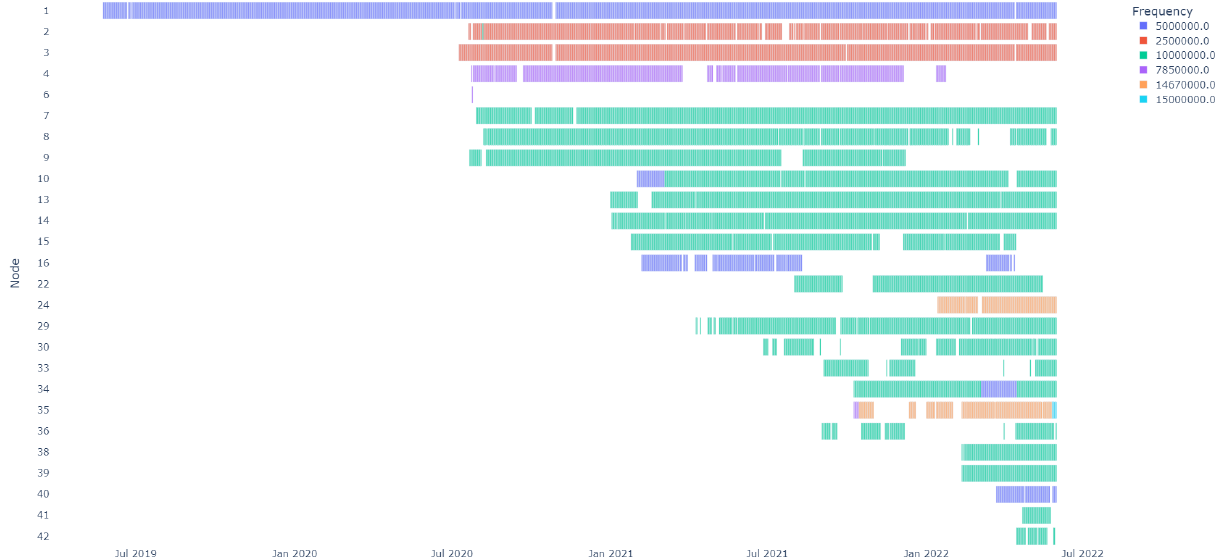
Figure 4. A data inventory, produced with a Gantt plotting tool in Plotly Express (Plotly Technologies, 2015), showing the data collected by each